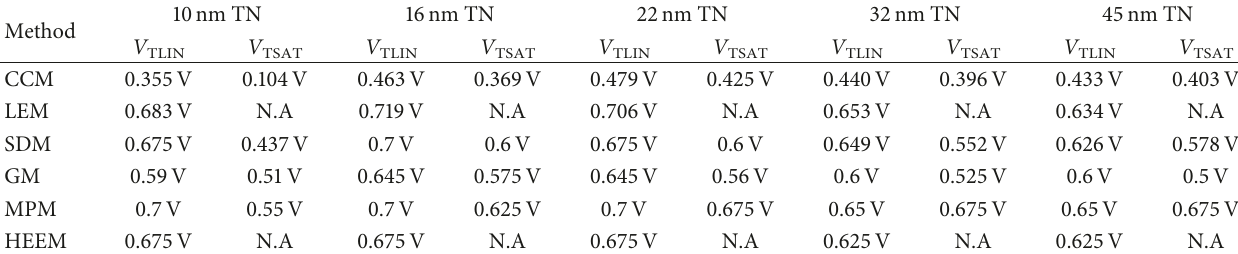
Table 3: Comparison of the simulation results of V TH extraction methods for various sub 45nm technologies.